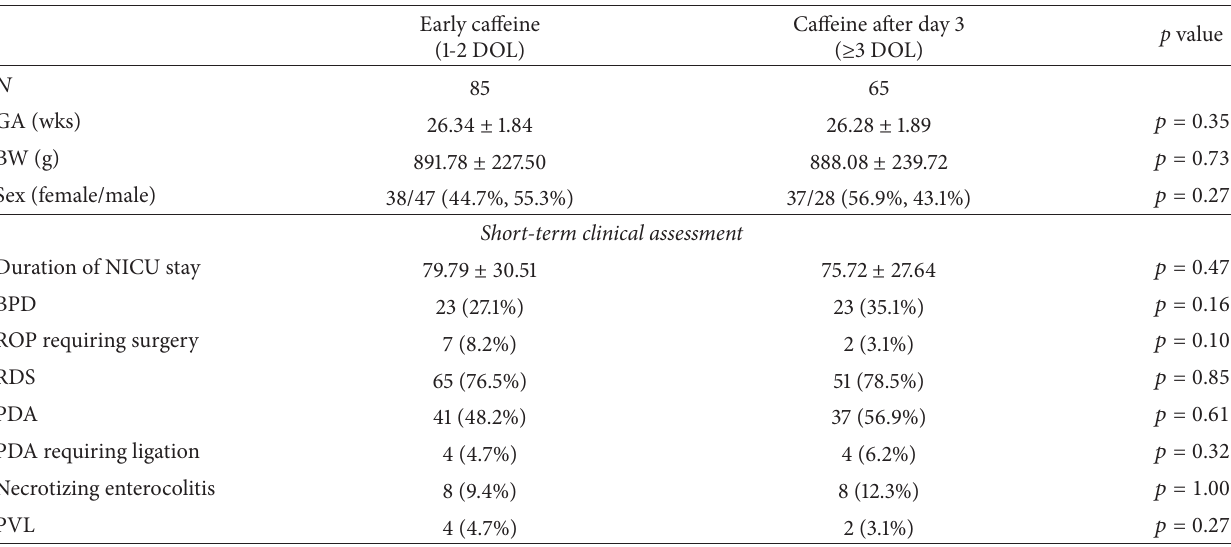
Table 3: Neonatal outcomes of infants receiving early caffeine (1-2 DOL) and all infants with caffeine ≥ 3